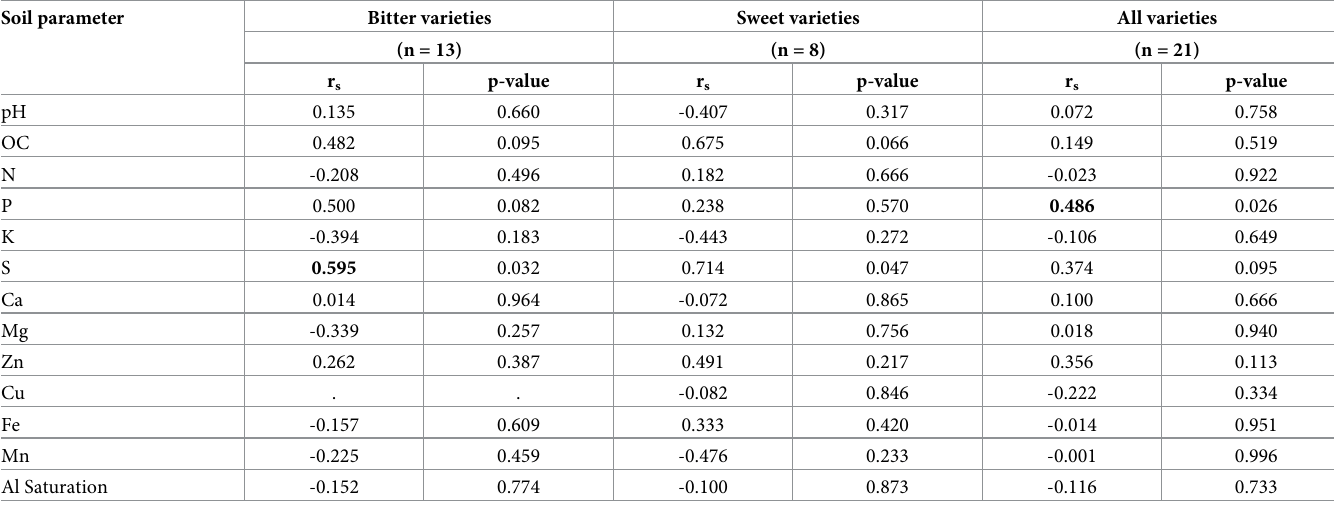
Values of correlation coefficients (r s ) in bold are significant at p < 0.05 using the Spearman’s correlation